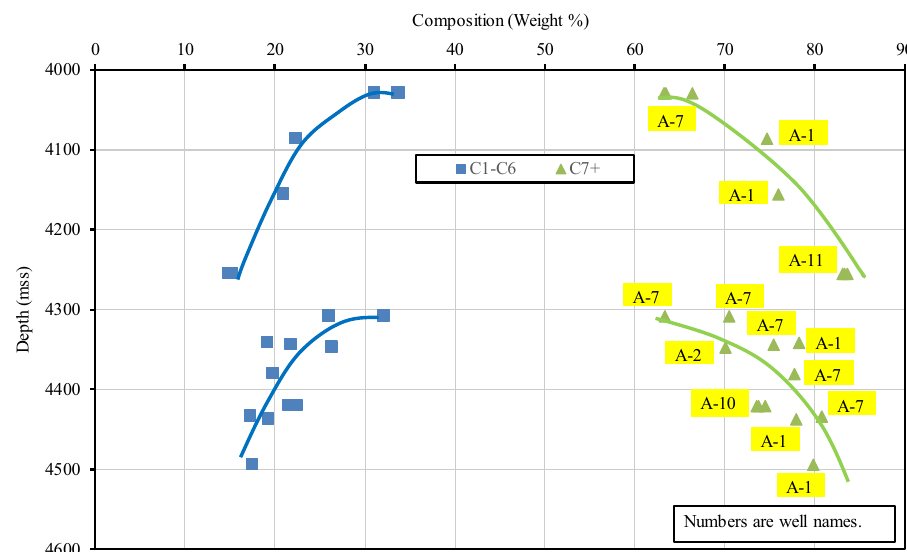
Fig. 7 Vertical reservoir fluid distribution (weight percent, two pseudo-components)